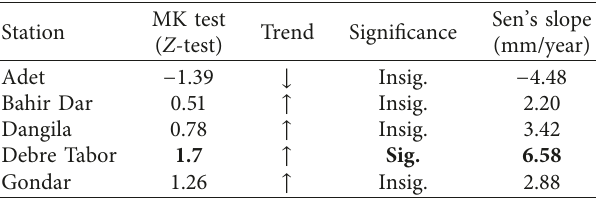
Table 5: Mann–Kendall and Sen’s test results of annual